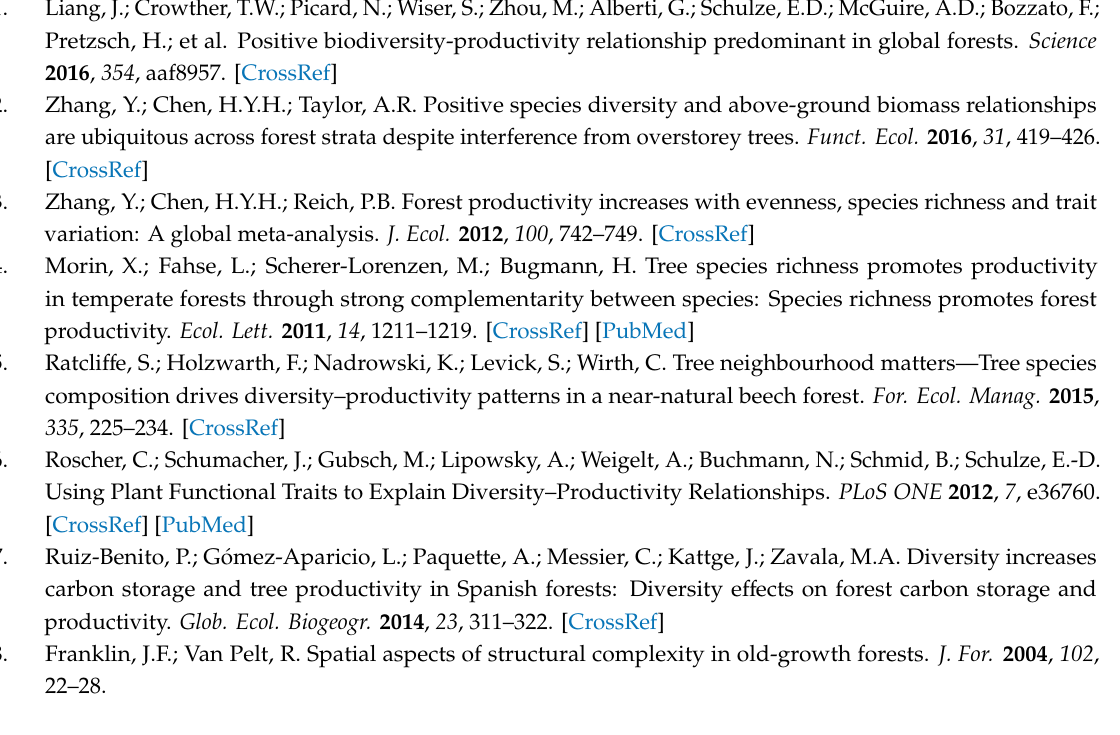
Figure S1. Variation in (A) fine root biomass and (B) root dry matter content of black spruce and trembling aspen with soil C:N ratio, total N, ammonium, phosphorus, potassium exchangeable cations (CEC) concentration within the three soil horizon layers in pure and mixed stands, Table S1. Summary of soil chemical properties (mean and SEM), Table S2. E ff ect p values of the analysis of covariance for spruce, Table S3. E ff ect p .values of the analysis of covariance for